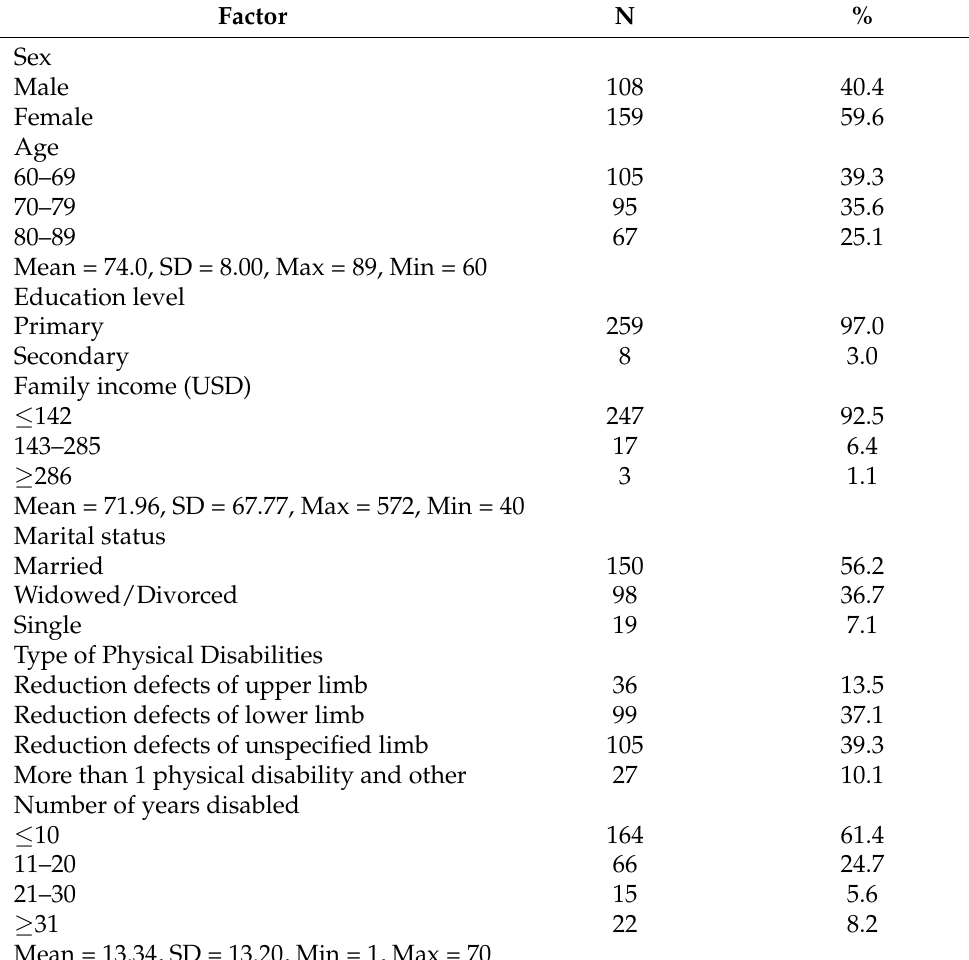
Table 1. Participant